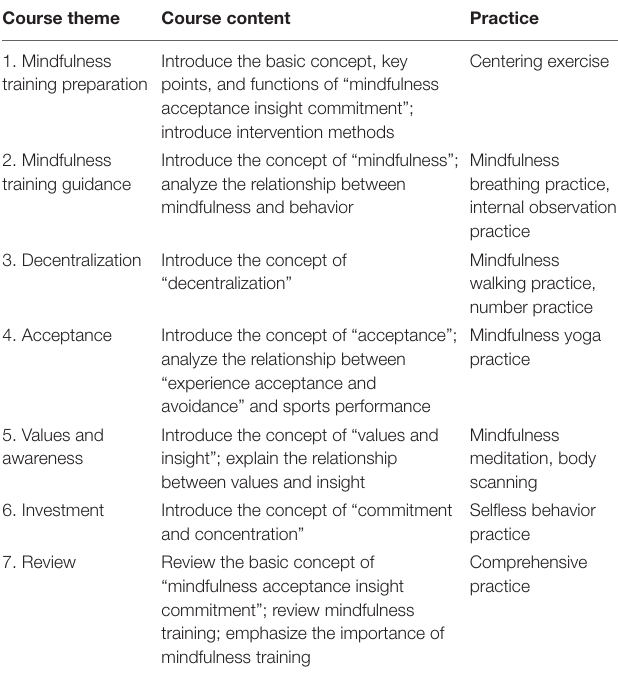
TABLE 1 | Mindfulness acceptance insight commitment course